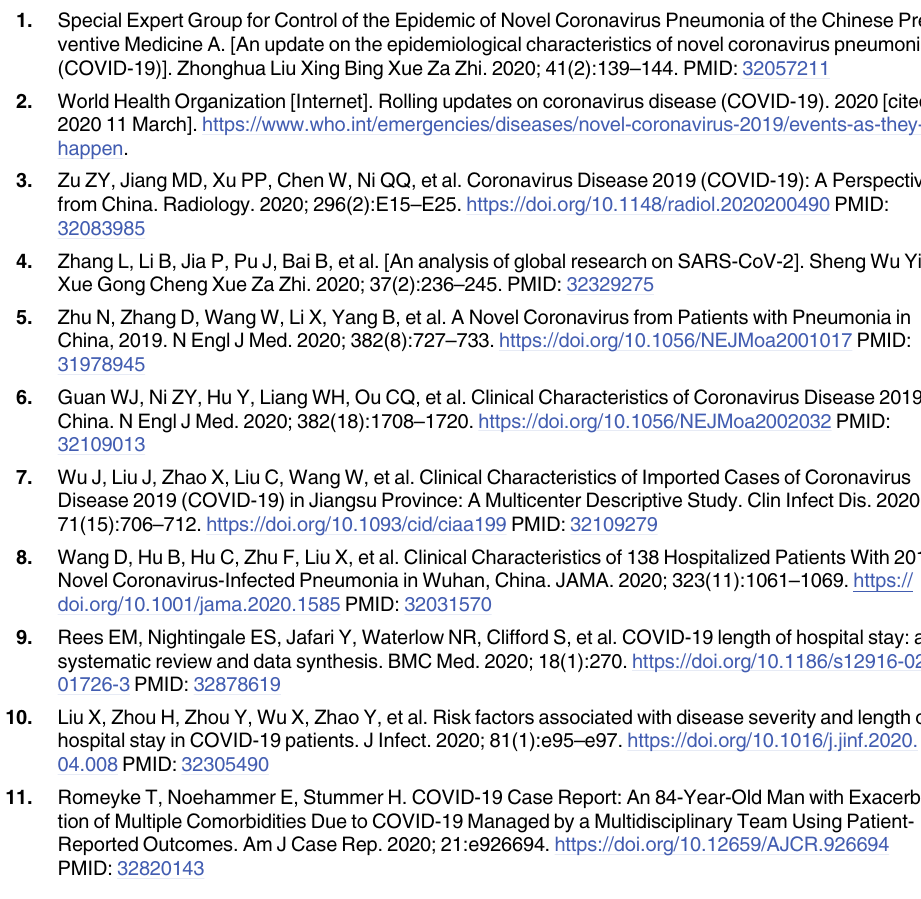
S2 Fig. Sensitivity analysis of risk factors’ hazard ratio (HR) of excluding the three deaths.